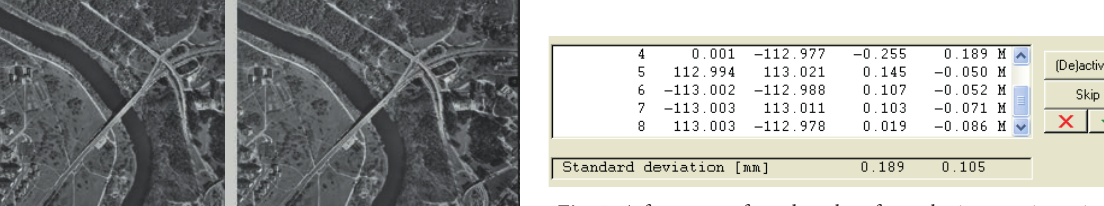
Fig. 4. The workflow of experimental study